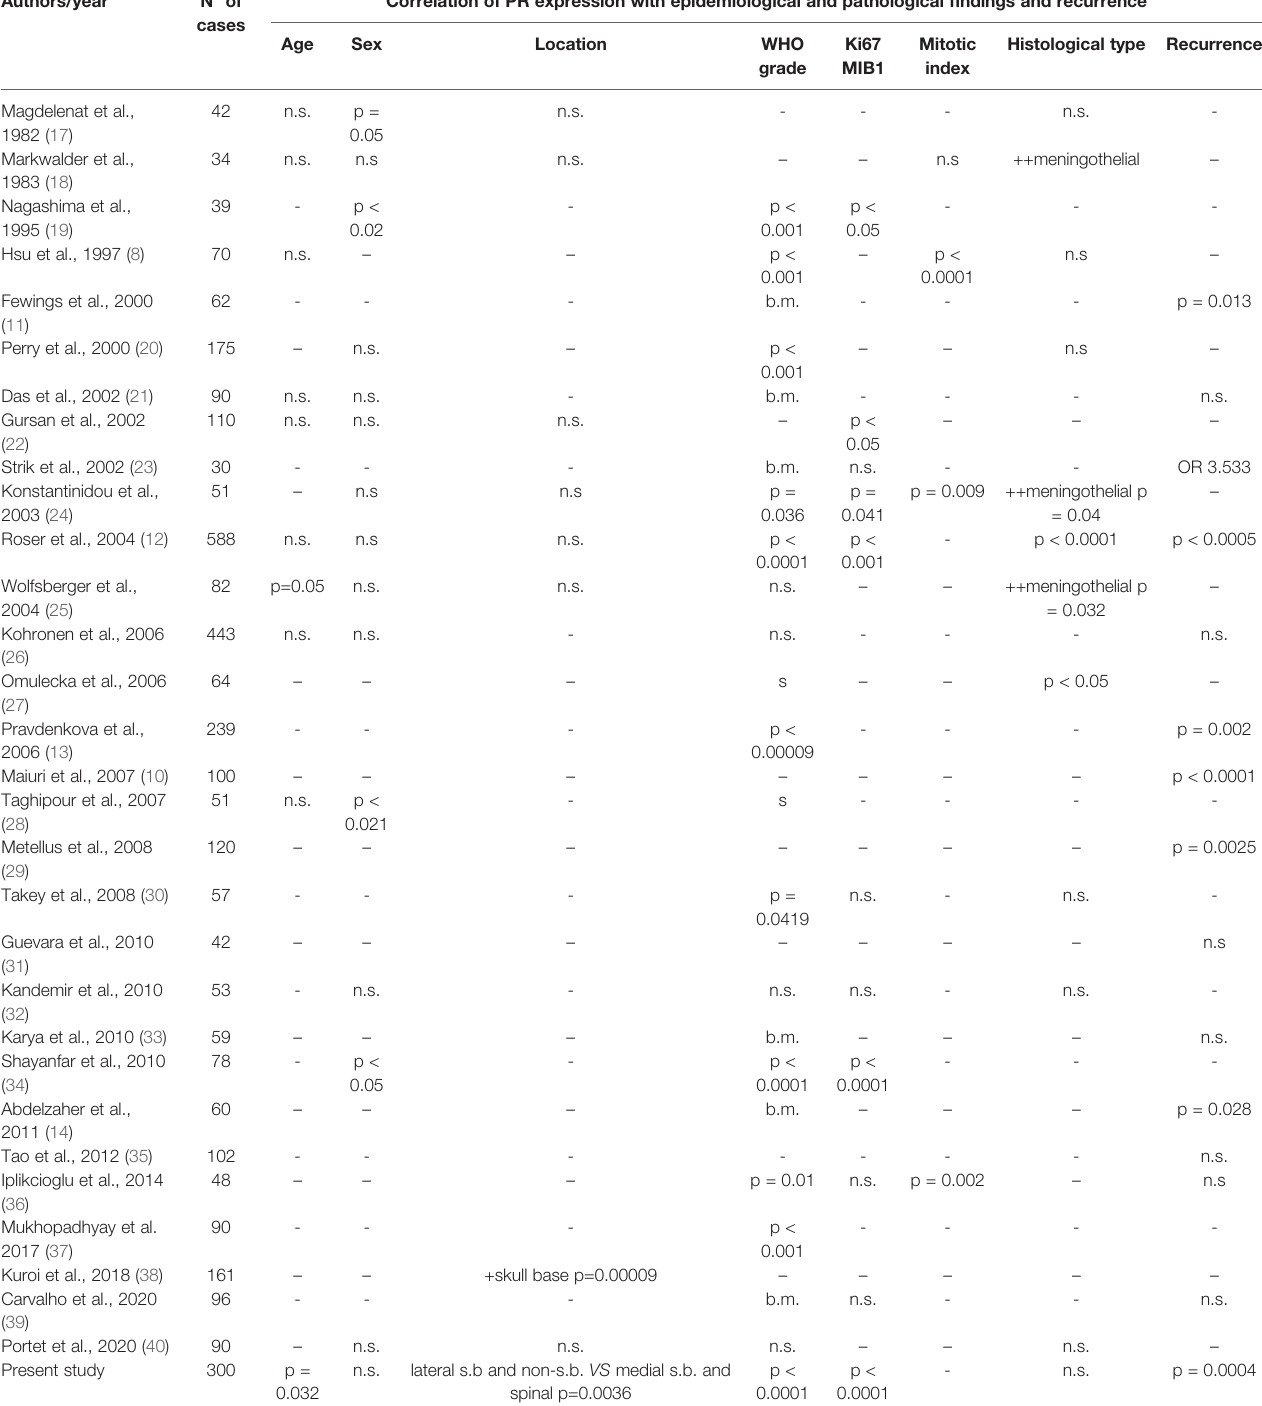
TABLE 9 | Data of 30 reviewed studies on the progesterone receptor expression in meningiomas. Authors/year N° of